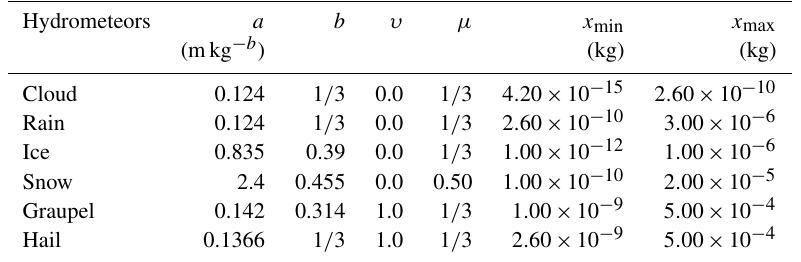
Table 1. Hydrometeor parameters for mass-diameter relationship and generalized gamma distribution for the of two-moment microphysics scheme including minimum and maximum values of mean particle mass.